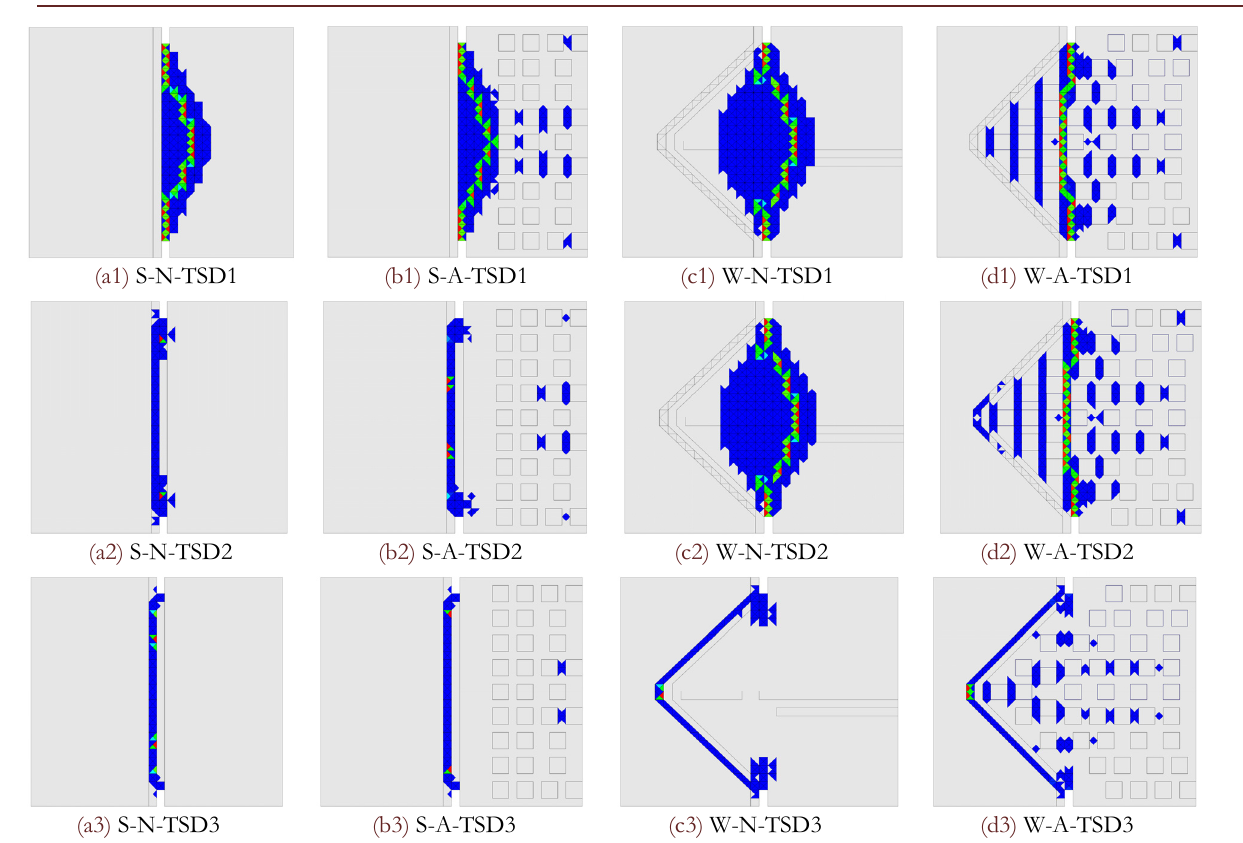
Figure 10: Crack distribution in models at the final stage of fracture.